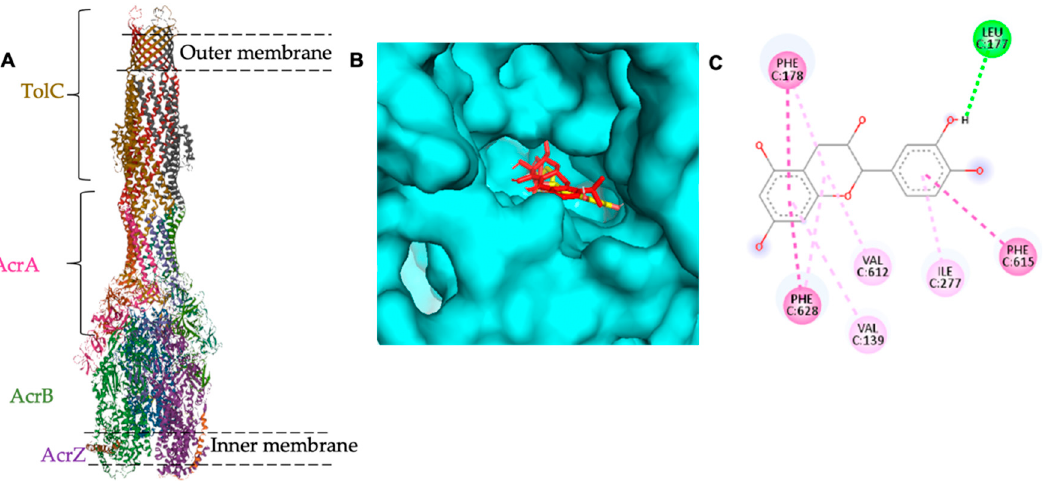
Figure 3. ( A ) Cryo-EM asymmetric structure of AcrBZ-Tolc pump of E. coli at 6.50 Å resolution (PDB-ID: 5NG5). ( B ) Binding affinity of catechin to AcrB protein of E. coli (docked catechin in yellow whereas docked minocycline is in red color). ( C ) the amino acids involved in the binding site of catechin to AcrB protein. Table 3. Binding affinity of catechin to AcrB protein of E. coli.